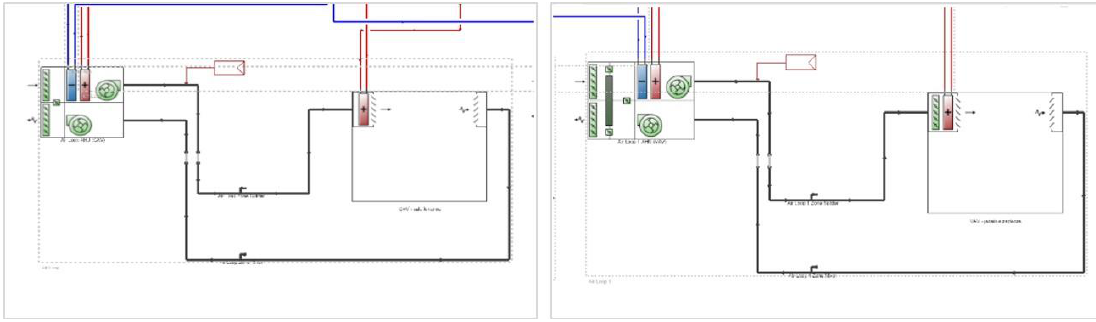
Figure 6. Diagram of the modeled constant air volume (CAV) system ( left ) and variable air volume (VAV) system ( right ).